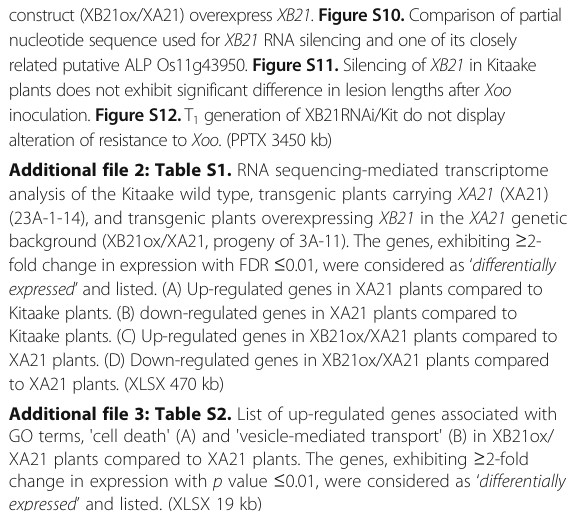
Additional file 3: Table S2. List of up-regulated genes associated with GO terms, 'cell death' (A) and 'vesicle-mediated transport' (B) in XB21ox/ XA21 plants compared to XA21 plants. The genes, exhibiting ≥ 2-fold change in expression with p value ≤ 0.01, were considered as ‘ differentially expressed ’ and listed. (XLSX 19